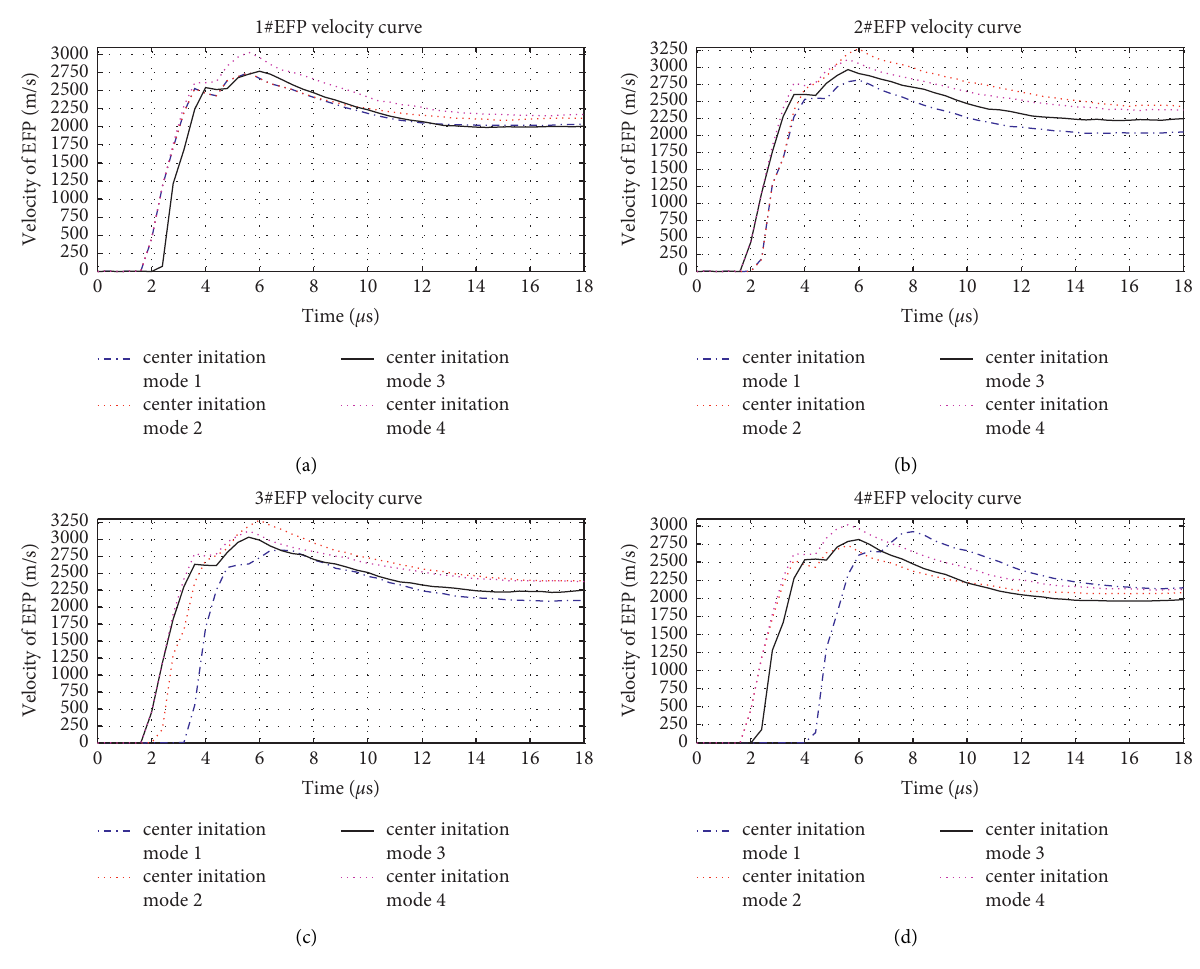
Figure 7: Comparison of forming